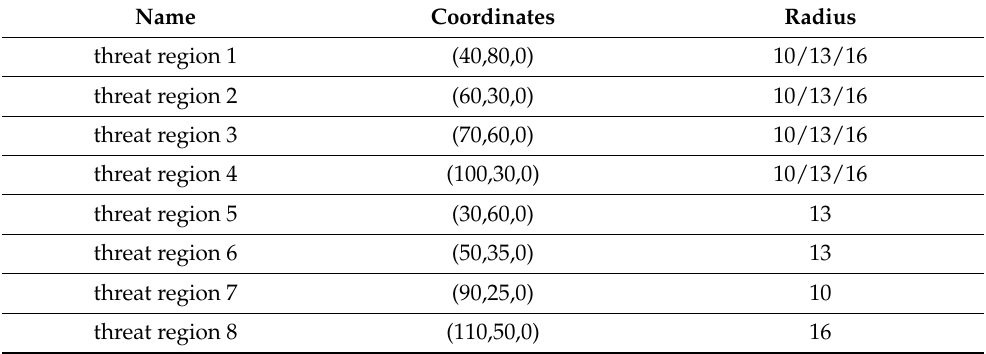
Table 1. The threat information of Case 1–4.